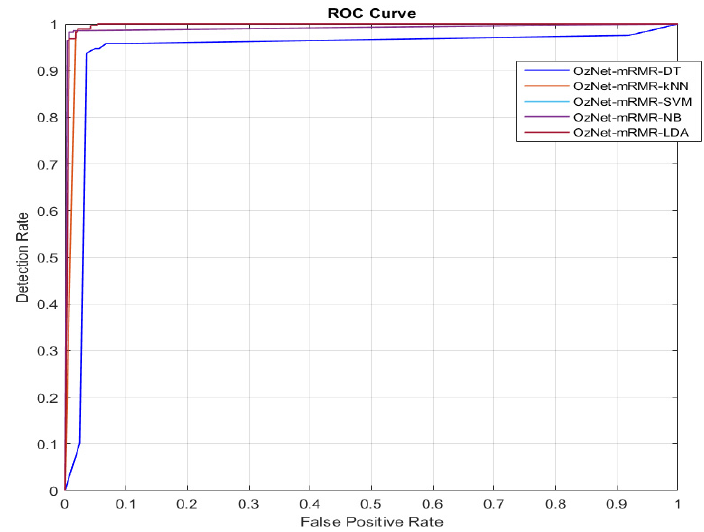
Figure 4. ROC Curves of OzNet hybrid algorithms.